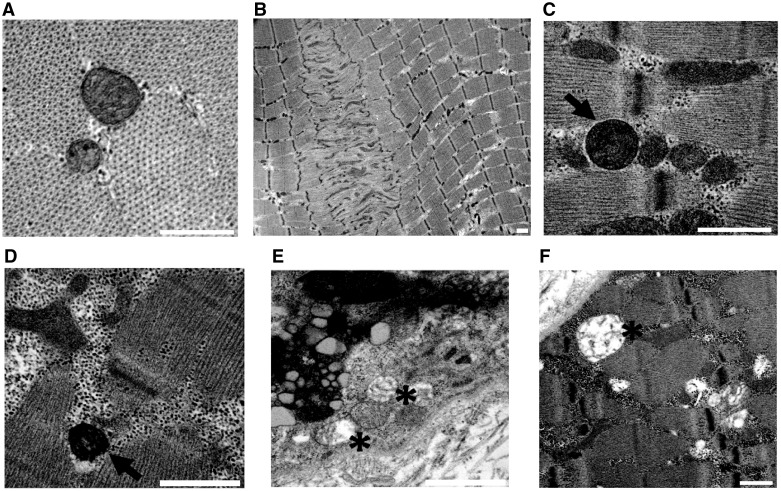
Mitochondrial abnormalities in the muscle of SBMA patients. (A) Representative image of TEM analysis of control muscle specimens. Representative images of TEM analysis of SBMA muscle specimens. (B) TEM analysis revealed myofibrillar disorganization and Z-line streaming. (C, D) Degenerated mitochondria with dense matrix (arrows). (E, F) Mitochondria with dilated-hypodense matrix and swelling (asterisks). Scale bar, 1 μm.